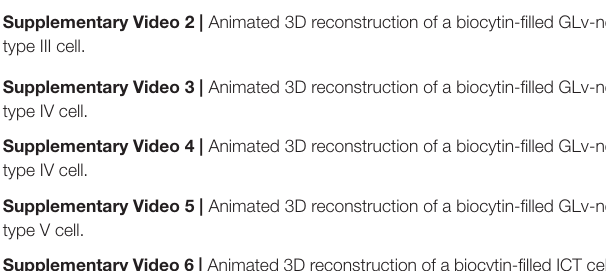
Supplementary Video 6 | Animated 3D reconstruction of a biocytin-filled ICT